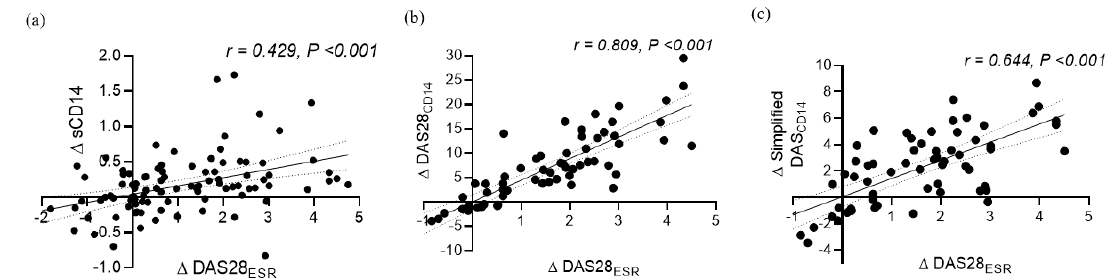
Figure A2. Comparison of urinary sCD14 concentrations measured by the FREND™ system with RA disease activity and treatment outcome. ( A ) Linear correlation between urinary sCD14 and the DAS28 ESR . ( B ) ROC curve analysis of urinary sCD14 versus CRP levels for differentiating low RA activity from moderate-to-high RA activity. Two AUCs were compared using two-sided statistical tests and p -values were calculated. ( C ) Urinary sCD14 levels according to EULAR treatment response, and ( D ) ROC curve analysis of Δ urinary sCD14 (sCD14 level at baseline to the sCD14 level at 6 months after treatment with anti-rheumatic drugs) for differentiating good responders from moderate-to-no responders. The AUC value for changes in CRP ( Δ CRP) is shown for comparison. Two AUCs were compared, and the p -value does not indicate a significant difference between them.